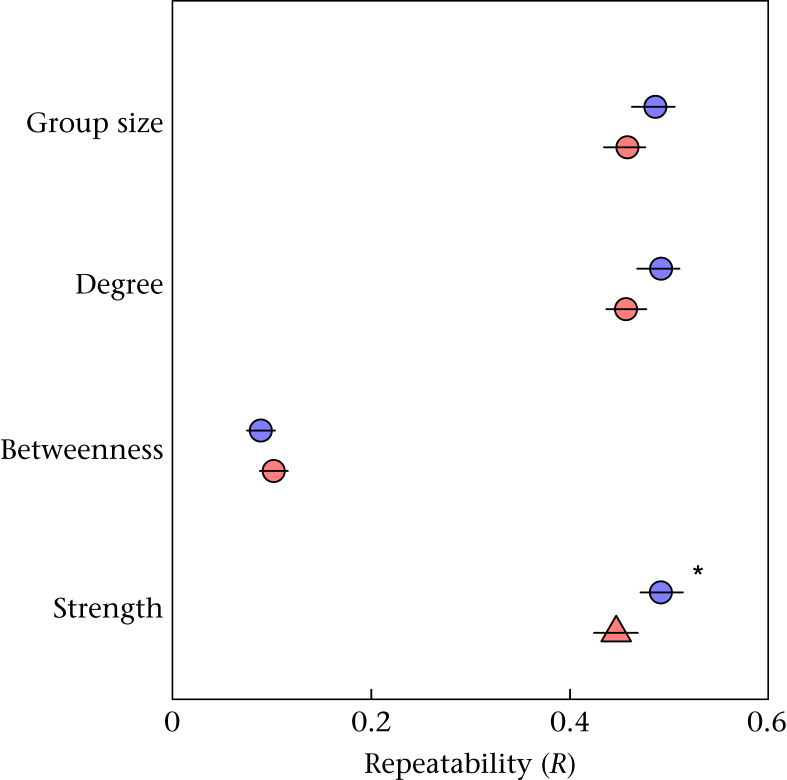
The repeatability measures for the different sex classes, showing the 95% confidence interval for each measure. Nonoverlapping confidence intervals at the 95% level are marked with an asterisk. Group size and degree measures do not overlap at the 84% confidence interval (nonoverlapping 84% confidence intervals are equivalent to a z-test at the 0.05 level). All 41 repeated social networks across 3 years were used to calculate repeatability estimates, additionally controlling for year (1–3). Blue nodes are males; red nodes are females.